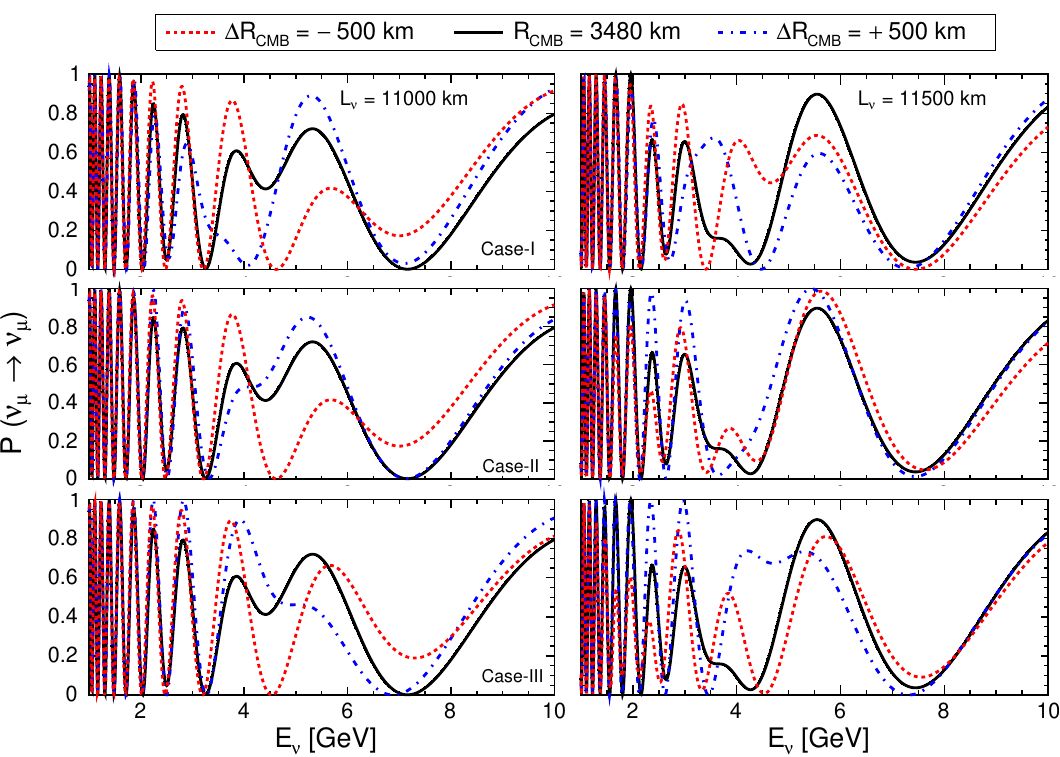
Figure 3 . The three-flavor ν µ → ν µ survival probability as a function of neutrino energy E ν . The solid-black, dotted-red, and dashed-blue curves represent the scenarios of standard core ( R = CMB 3480 km), SC ( ∆ R = − 500 km), and LC ( ∆ R = + 500 km), respectively. The top, CMB CMB middle, and bottom panels correspond to the Case-I, Case-II, and Case-III, respectively. The left (right) panels consider the neutrino baseline L of 11000 (11500) km. We use three-flavor neutrino ν oscillation parameters given in table 2, where we assume NO and sin 2 θ = 23